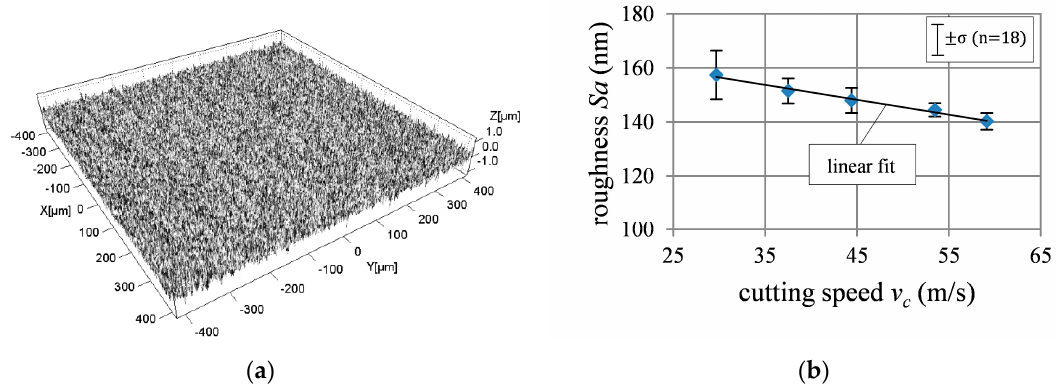
Figure 3. ( a ) White light interferometer (WLI) measurement (20× magnification): 2D-surface roughness ( v c = 30 m/s, Sa = 160 nm); ( b ) Surface roughness Sa for different cutting speeds (distance from workpiece center 15 mm) with linear fit.